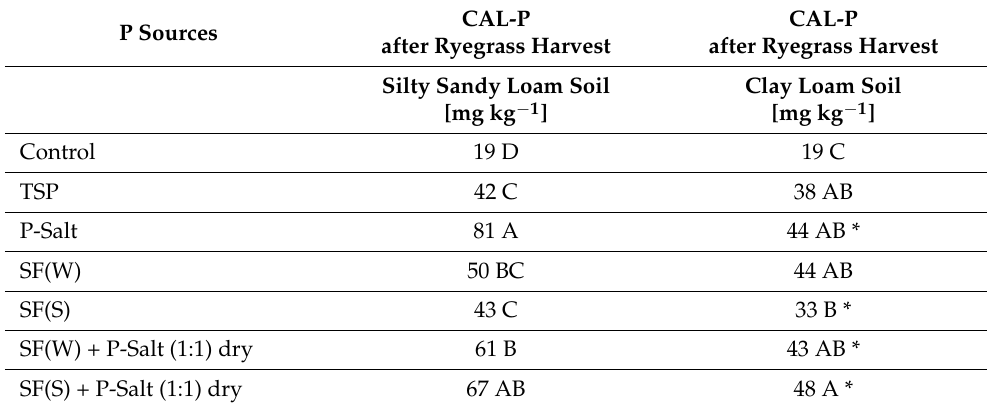
Table 2. CAL-extractable P (CAL-P) in